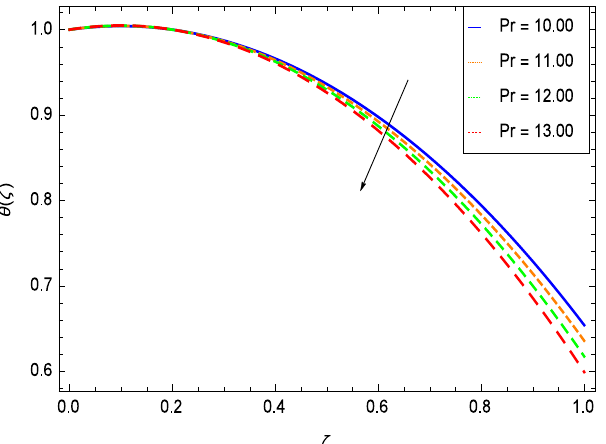
Figure 19. Conduction layer at h = − 1.80, β = 0.10, φ = 0.40, n = 1.50, We = 0.50, M = 0.50, Nr = 1.00, S = 0.50, A 3 = A 4 = 0.20, A = π with the enhancement in Pr . 4